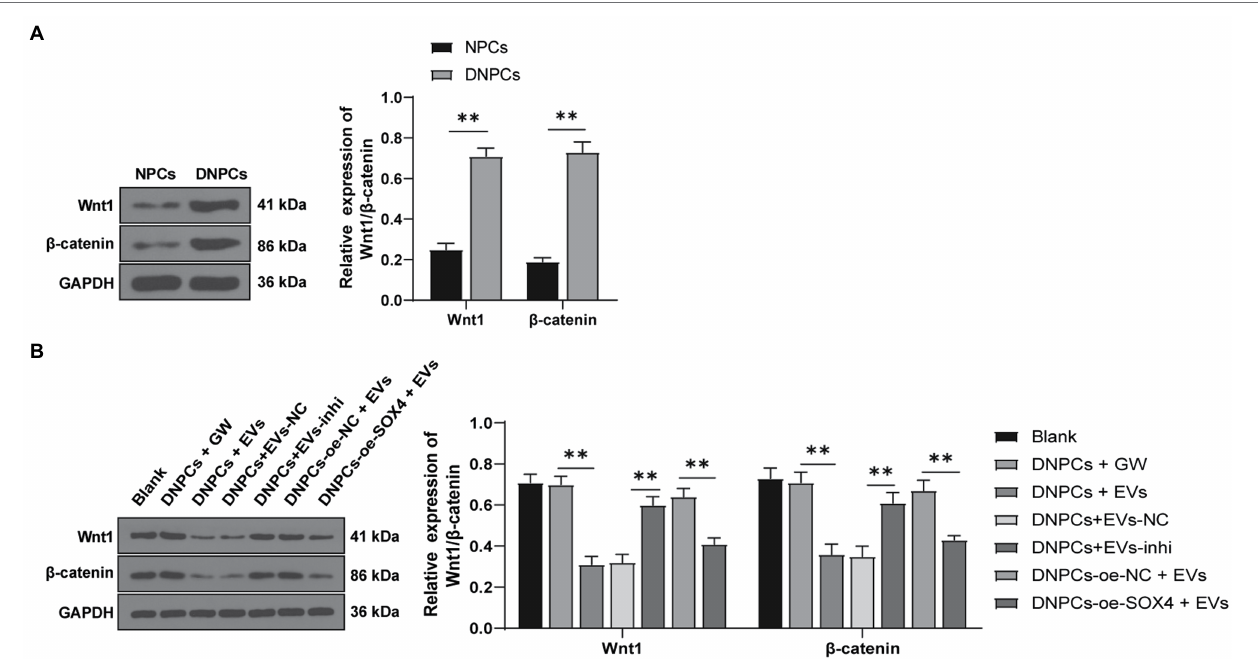
FIGURE 7 | Extracellular vesicles inhibited the activation of Wnt/ β -catenin pathway via the miR-129-5p/SOX4 axis. (A) Expressions of Wnt1 and β -catenin in NPCs and DNPCs detected by Western blot; (B) expressions of Wnt1 and β -catenin in DNPCs in different treatment groups. Cell experiment was repeated three times. Data were presented as mean ± standard error. Data in panel (A) were analyzed using independent t test and data in panel (B) were analyzed using one-way ANOVA, followed by Tukey’s multiple comparisons test. ** p <